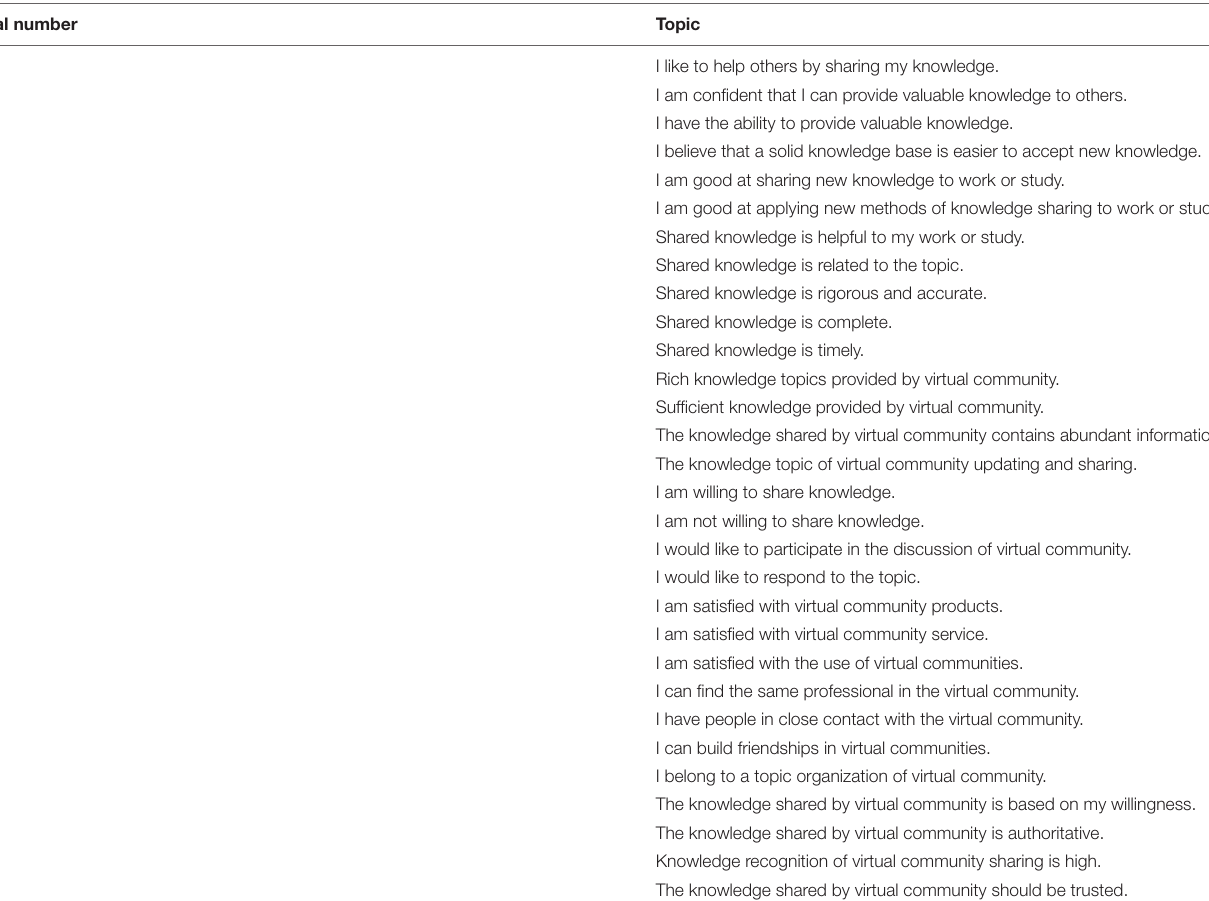
TABLE TA1 | Scale of sustainable knowledge sharing in virtual academic